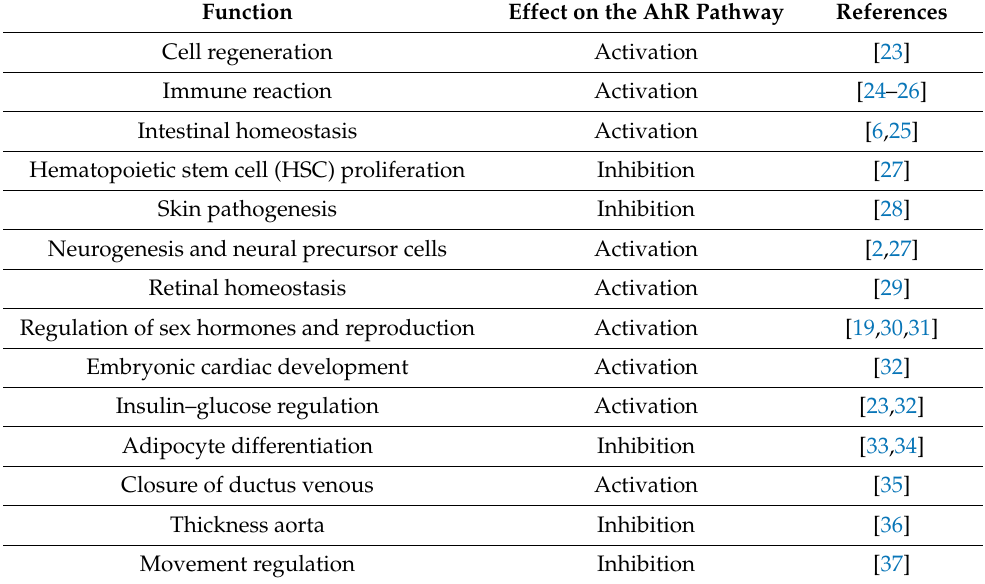
Table 1. The effect of aryl hydrocarbon receptor (AhR) signaling in physiological functions. Function Effect on the AhR